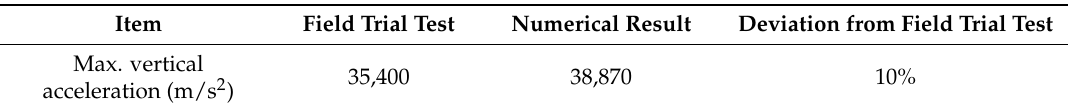
Table 7. Vertical acceleration of the multi-layer pavement slab.